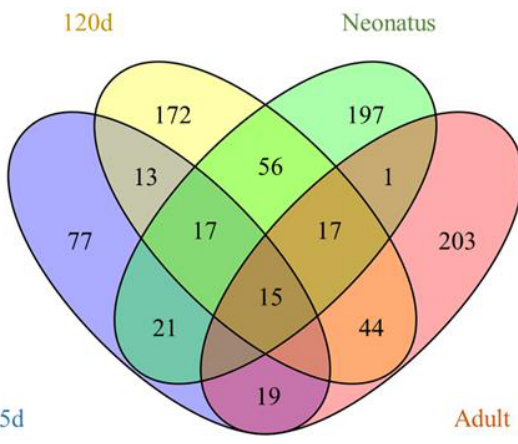
Figure 5. Venn diagram showing the differentially expressed lncRNAs at the four stages.